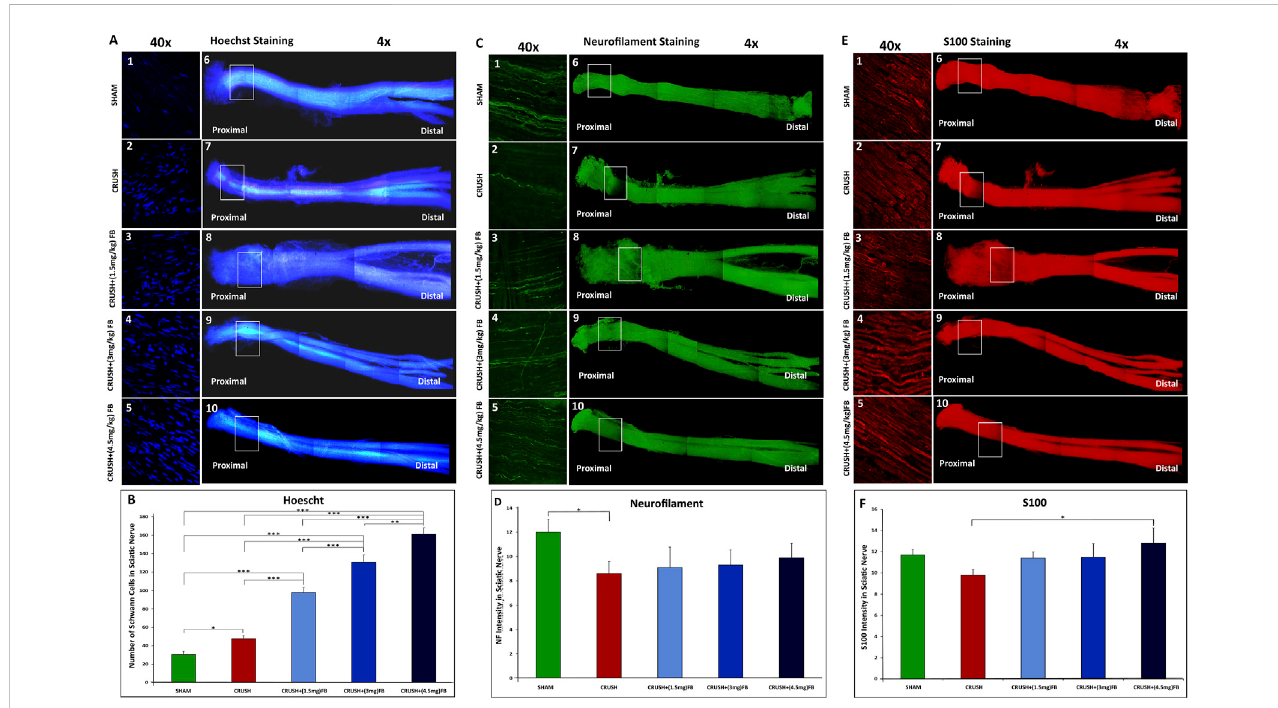
FIGURE 3 (A – F) : Visualization of axonal regeneration using whole-mount staining of the crushed sciatic nerve. (A) Comparison of the number of individual SC nuclei among experimental groups . (A1-5) representative images of Hoechst stained nuclei located at the crush injury site magni fi ed from (A6-10) representative images. (B) The graph shows the quanti fi cation of Hoechst-stained nuclei. The number of nuclei in the fi eld was analyzed from three or four sections, and average data from fi veindependentexperimentalgroups were compared. Data are expressed as mean± SEM (n = 8).* p < 0.05, ** p < 0.01, *** p < 0.001. (C) Re-growing axons of the sciatic nerve. The sciatic nerve is stained with neuro fi lament antibody 4 weeks after nerve crush injury (C6-10). At this point, more regenerating axons have grown within the FB-treated groups (C3-5) compared to the crush group (C2). (D) Neuro fi lament intensity was quanti fi edinthegraphusing4differentsectionsofthecrushinjurysite.Dataareexpressedasmean±SEM(n=8).* p < 0.05. (E) ExpressionofS100inSCsafter 4 weeks from crush sciatic nerve injury. Images (E 6-10) represent whole-mount sciatic nerve preparations at the crush injury site. Higher magni fi cation of crushsitein (E1-5) showsS100positiveSCs. (F) S100intensitywasquanti fi edinthegraphusing4differentsectionsofthecrushinjurysite.Dataareexpressed as mean ± SEM (n = 8). * p <